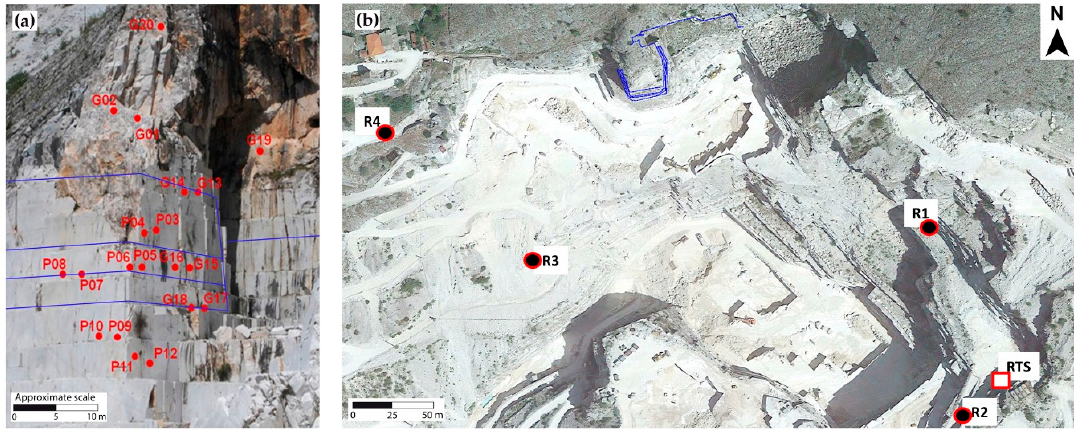
Figure 4. ( a ) Perspective photograph of the marble buttress with RTS measurement prisms (red points) and the DOFS trace (blue lines). ( b ) UAV-orthophoto showing the position of RTS, reference prisms (black and red points) and fiber optics (blue lines).